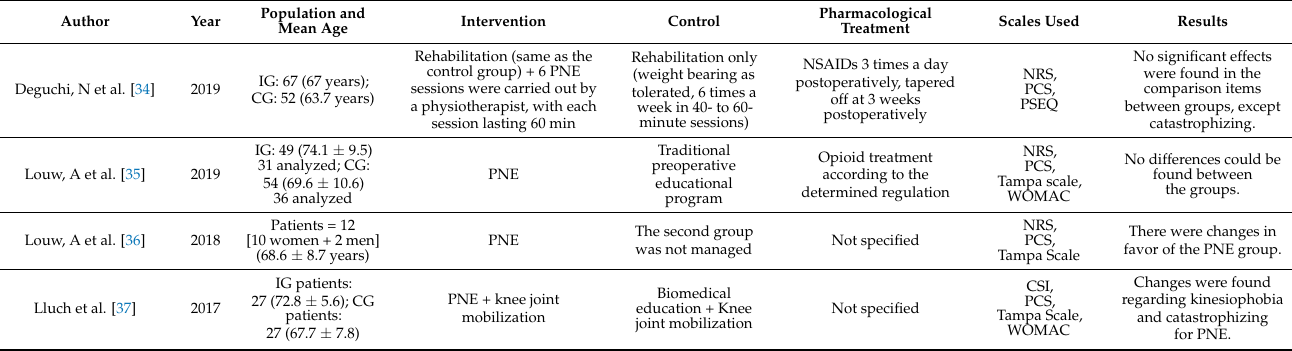
Figure 1. Search flowchart. Source: Own source. Table 1. Characterization of the